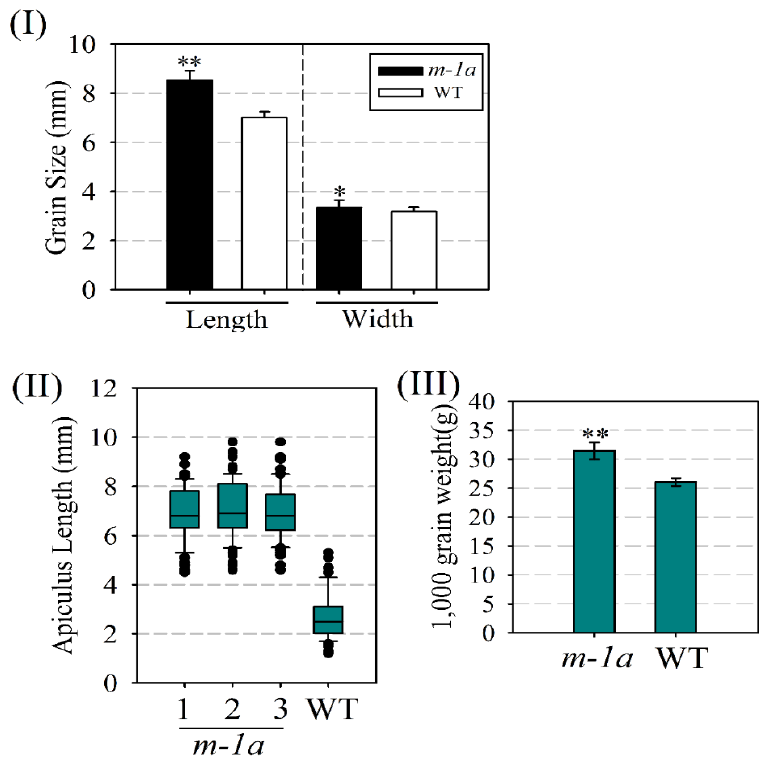
Figure 3. Comparison of the size of apiculus in m-1a and wild-type rice. ( I ) Comparison of grain length and width. ( II ) Comparison of apiculus length. ( II ) Comparison of 1000-seed weight. C1–3 = m-1a plants; WT = wild-type plants (‘Zhonghua 11’). Values represent the mean ± SD of triplicates. The asterisks indicate that the correlation coefficients were significantly different (* p < 0.05, ** p < 0.01).